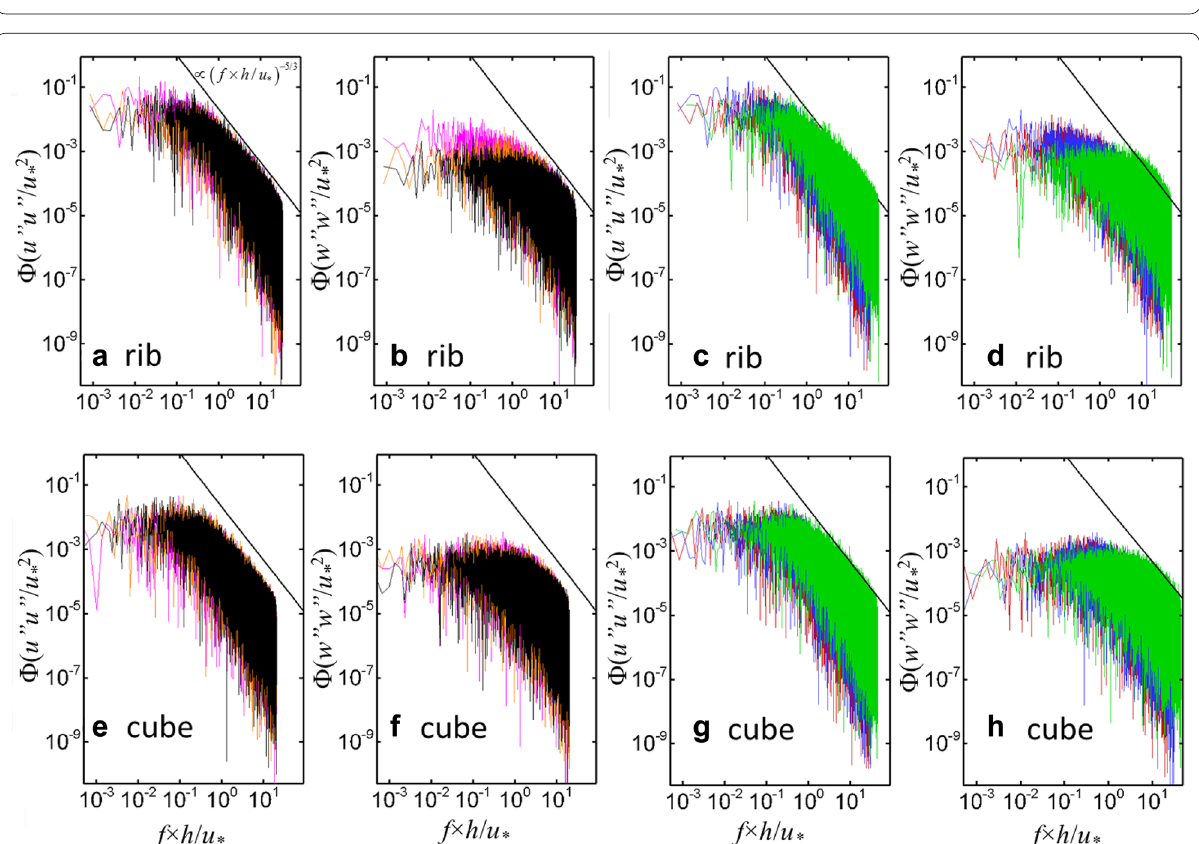
1, b AR 1/2, c AR 1/4, and d AR 1/8 and cube‑type arrays of e 1h:1l, f 1h:2l, g = = = =